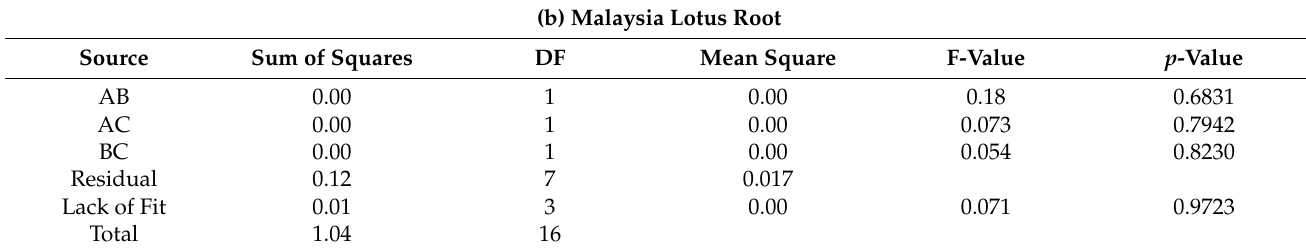
Table 1. Cont. (b) Malaysia Lotus